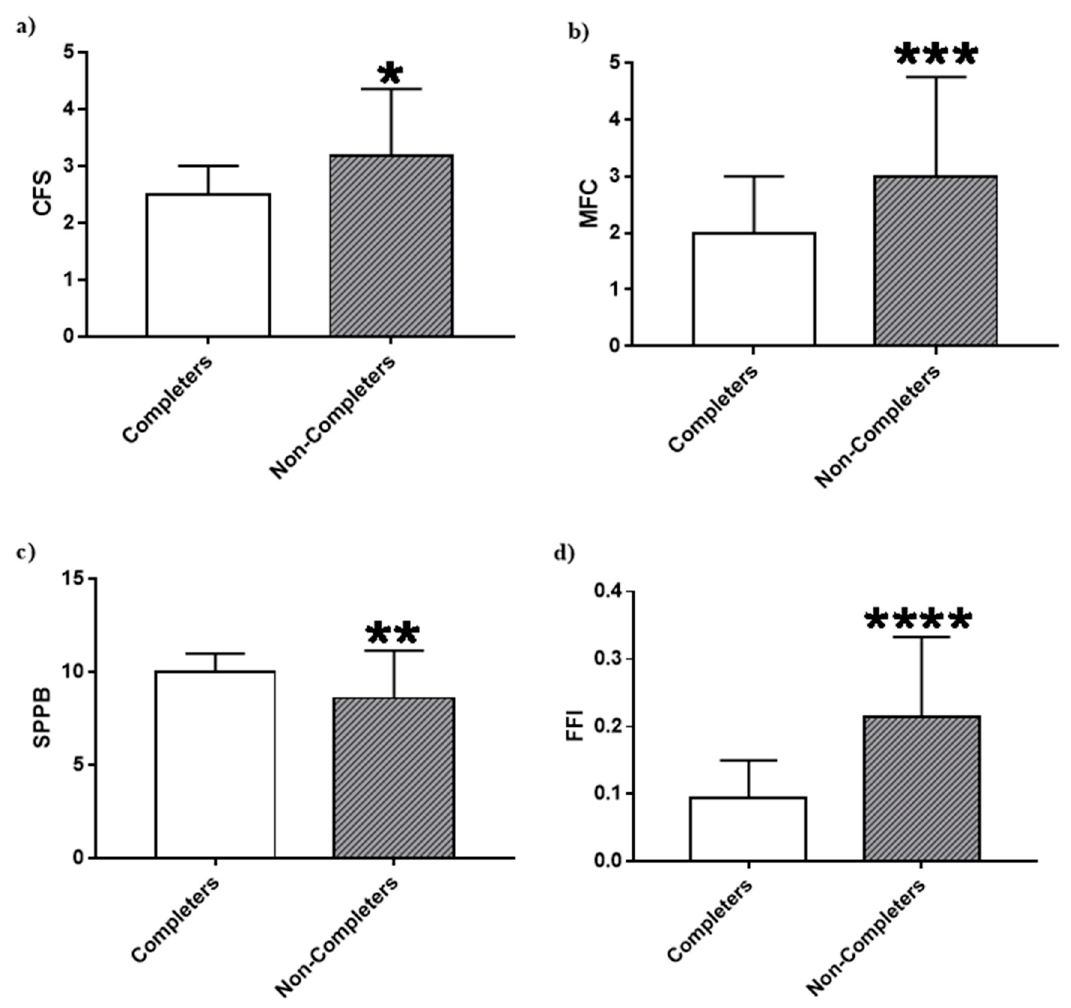
Figure 2. ( a ) Pre-operative CFS scores among CR completers and non-completers; ( b ) Pre-operative MFC scores among CR completers and non-completers; ( c ) Pre-operative SPPB scores among CR completers and non-completers; ( d ) Pre-operative FFI scores among CR completers and non-completers. Values are median ± interquartile range. Completers n = 48; non-completers n = 66. Statistical comparisons were calculated using a non-parametric Mann-Whitney test. * Non-completers different from completers ( p < 0.05), ** Non-completers different from completers ( p < 0.01), *** Non-completers different from completers ( p < 0.001), **** Non-completers different from completers ( p < 0.0001). A lower score for the CFS, MFC, and FFI signifies an individual who is less frail. However, the opposite is true for the SPPB, where a higher score signifies an individual who is less frail. CFS, Clinical Frailty Scale; MFC, Modified Fried Criteria; SPPB, Short Physical Performance Battery; FFI, Functional Frailty Index.